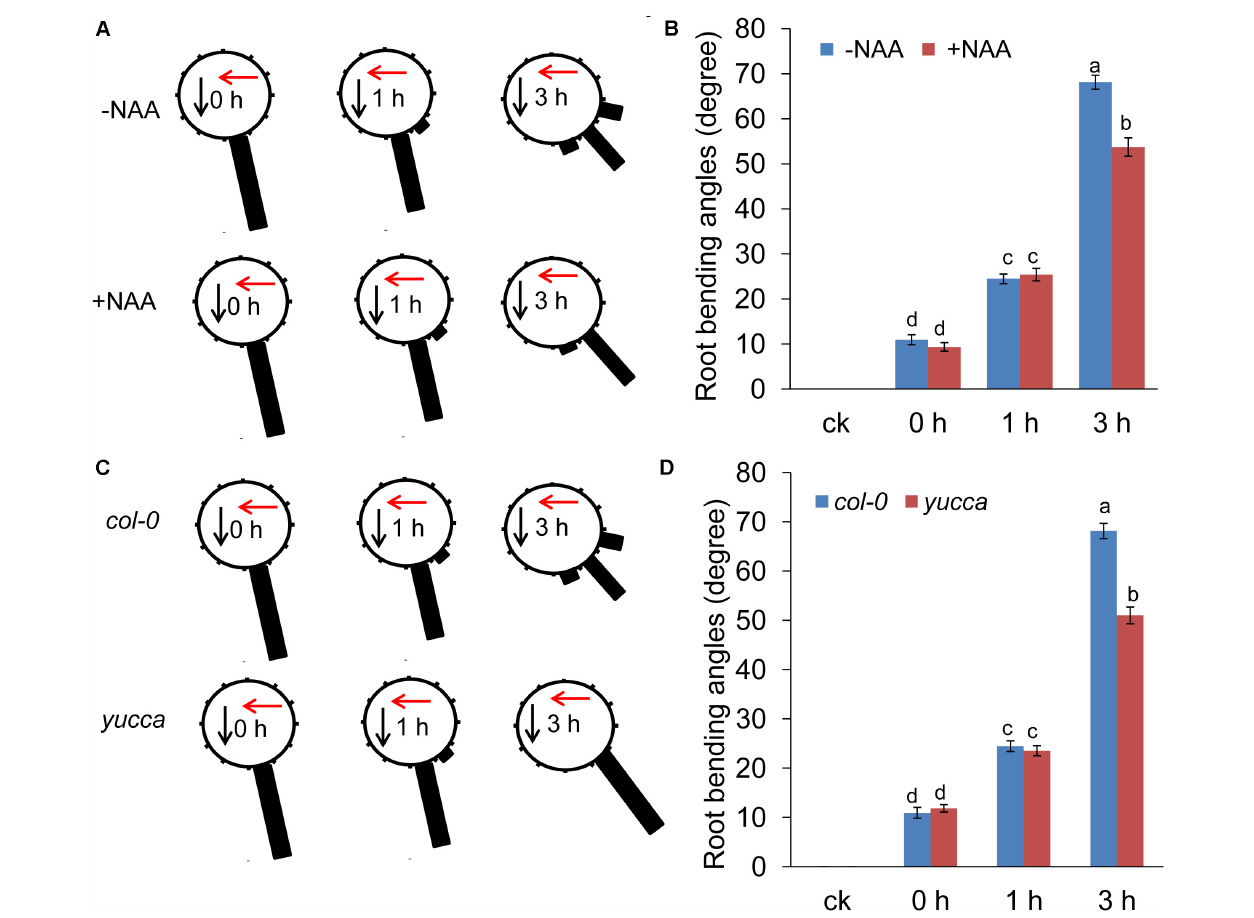
FIGURE 4 | Auxin is involved in UV-B-induced root bending. (A,B) The angle of root bending of the wild-type Col-0 seedlings irradiated with UV-B for 1 h and then transferred to normal growth conditions plus 0 nM NAA or 10 nM NAA for 0–3 h, n = 60. (A) Each gravistimulated root was assigned to 1 of the 12 30 ◦ sectors on a gravitropism diagram. The length of each bar represents the mean percentage of seedlings assigned to the respective sector. (B) The average root bending angles. (C,D) The angle of root bending of Col-0 and yucca seedlings irradiated with UV-B for 1 h and then transferred to normal growth conditions for 0–3 h. Col-0 , n = 60; yucca , n = 60. (C) Each gravistimulated root was assigned to 1 of the 12 30 ◦ sectors on a gravitropism diagram. The length of each bar represents the mean percentage of seedlings assigned to the respective sector. (D) The average root bending angles of Col-0 and yucca seedlings. The red and black arrows indicate the direction of UV-B radiation and gravity, respectively; ck, before UV-B radiation control. The error bars represent the ± SE, and different letters indicate significantly different values ( P < 0.01 by Tukey’s